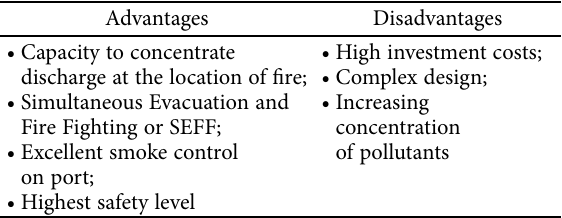
Table 1. Jet fans with spot extraction by axial fans ( A 1 )